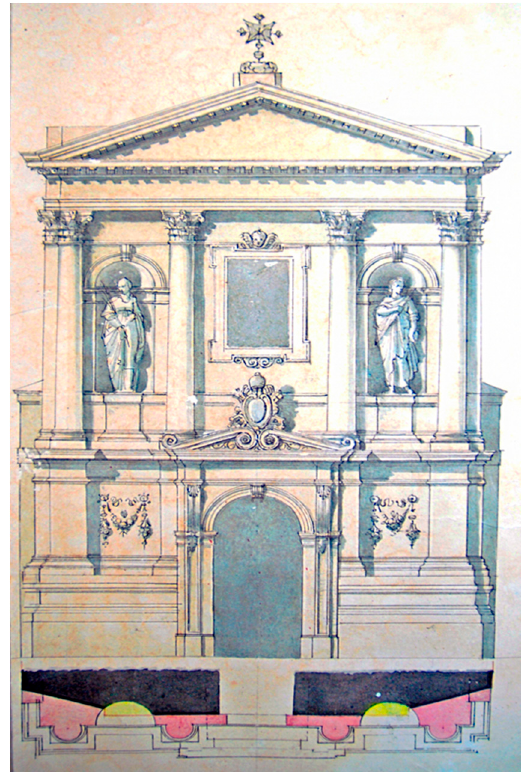
Figure 6. Original Carducci’s drawing of the façade project, preserved in the Historical Archive of Montedinove. The discovery and the sub sequential scanning of this document has been the base of the projecting test (from Relazioni e disegni di progetto della facciata della chiesa di San Lorenzo , Giovanbattista Carducci, Historical Montedinove Town Hall Archive,